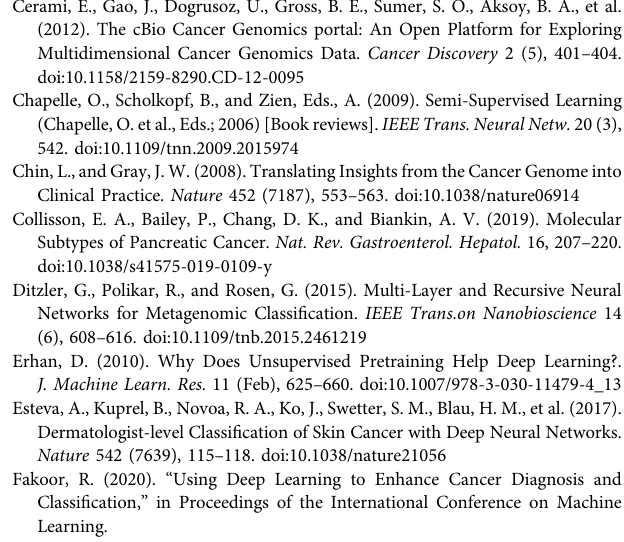
Figure 4 . Hence, its addition does not result in any